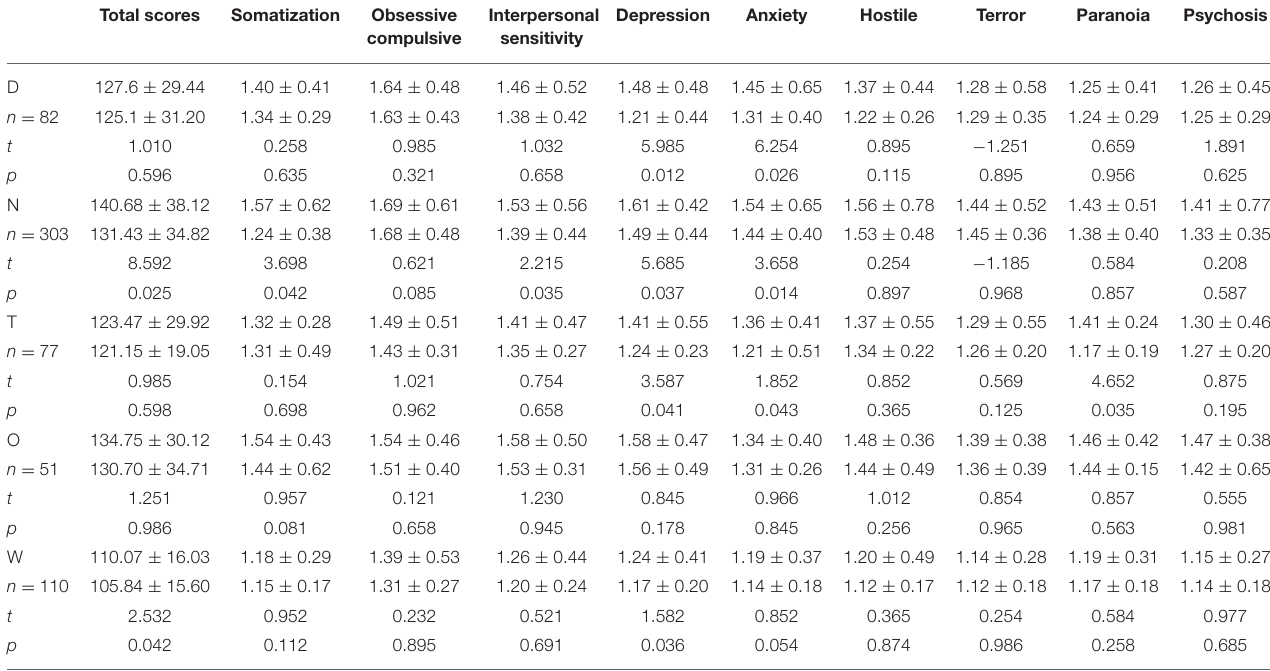
TABLE 8 | Total scores and scores based on each factor of the two SCL-90 evaluations(M ± SD). Total scores Somatization Obsessive Interpersonal Depression Anxiety Hostile Terror Paranoia compulsive sensitivity